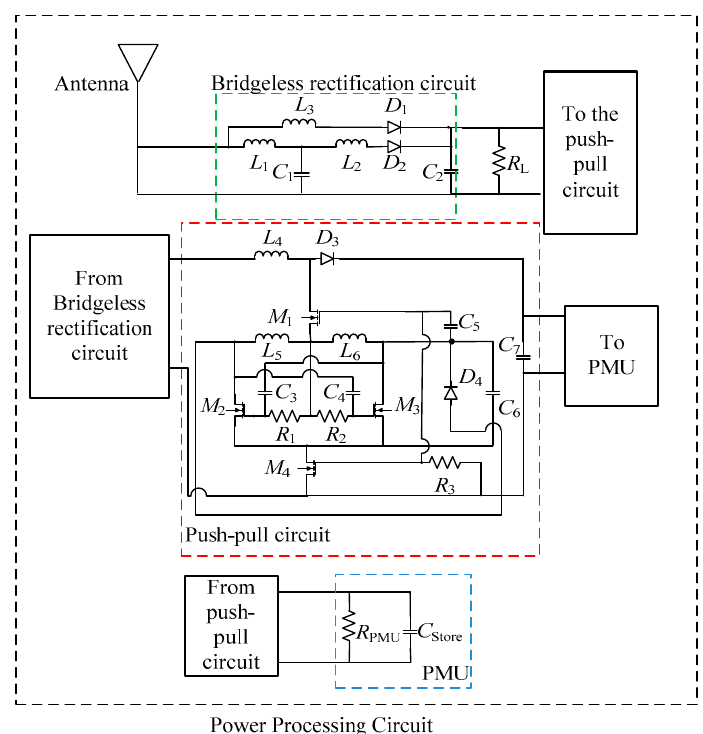
Figure 2. The schematic circuit of the proposed system.